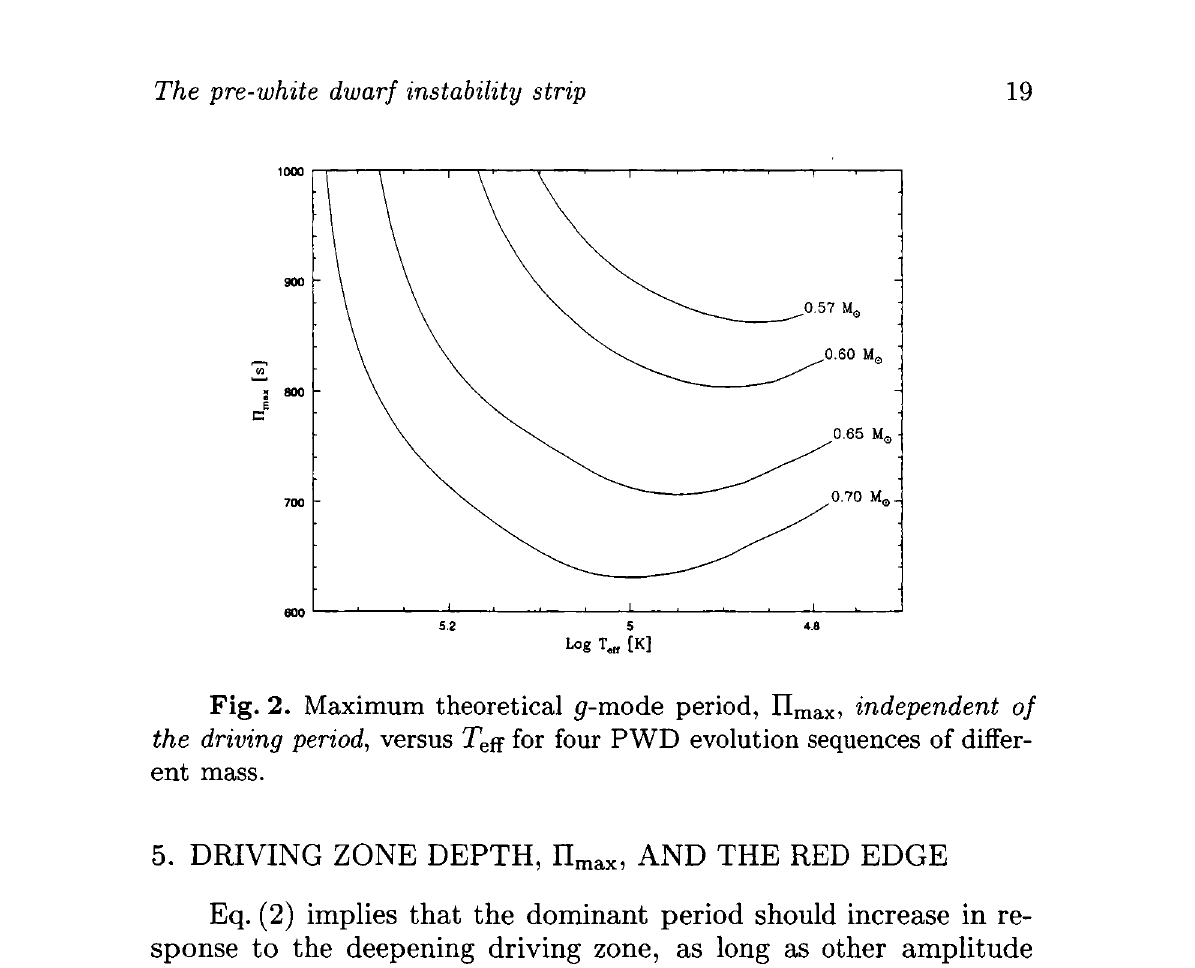
ff for four PWD evolution sequences of differ- e